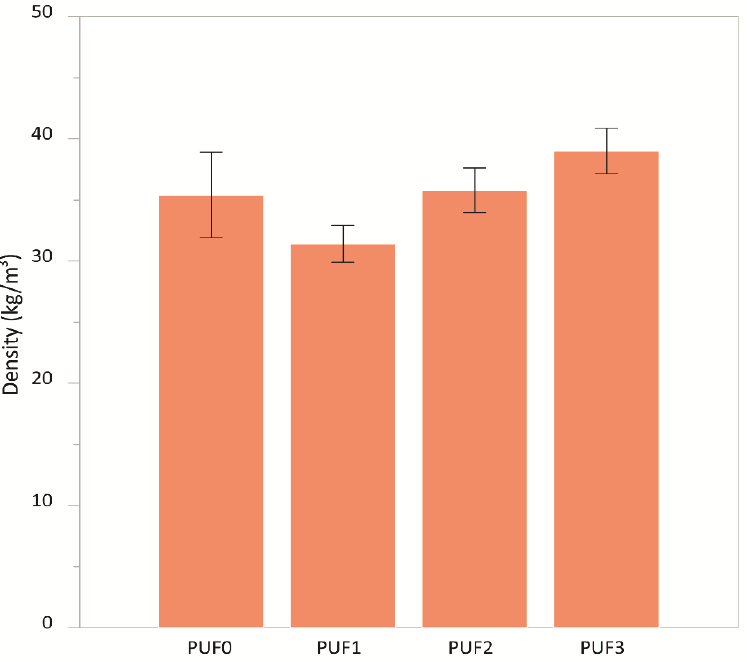
Figure 11. Density of synthesized polyurethane foams.